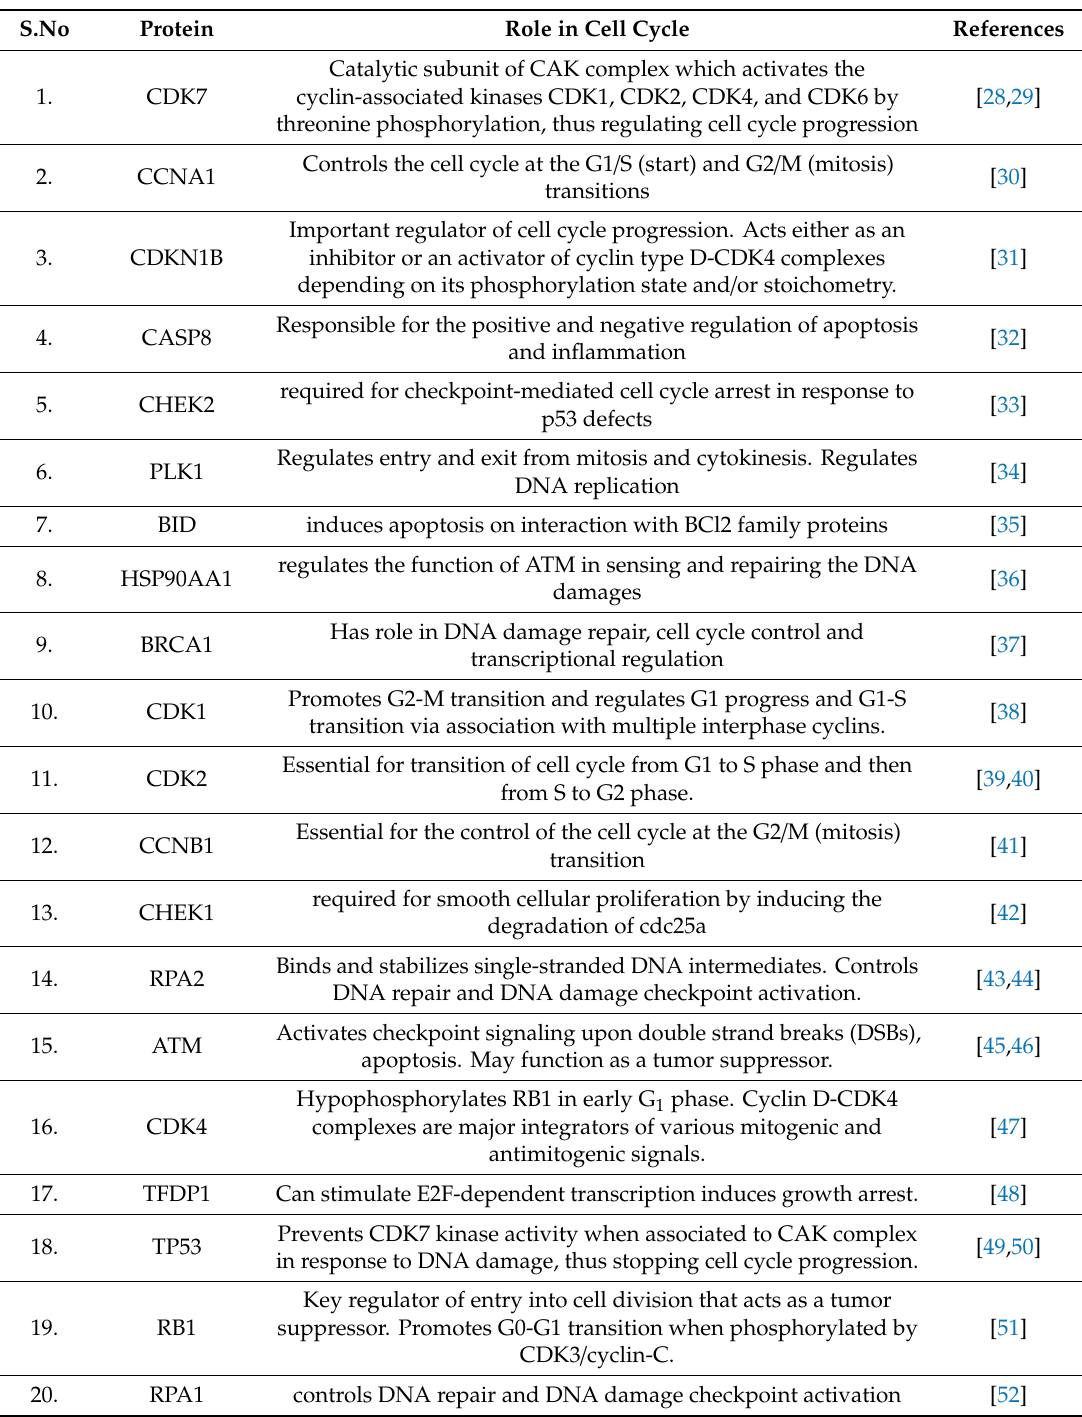
Table 5. Key proteins and their roles in cell cycle